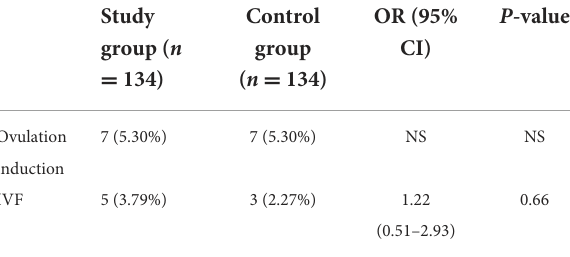
TABLE 3 Fertility treatments following the index delivery for women following conservative treatment for placenta accreta spectrum vs. age-parity matched